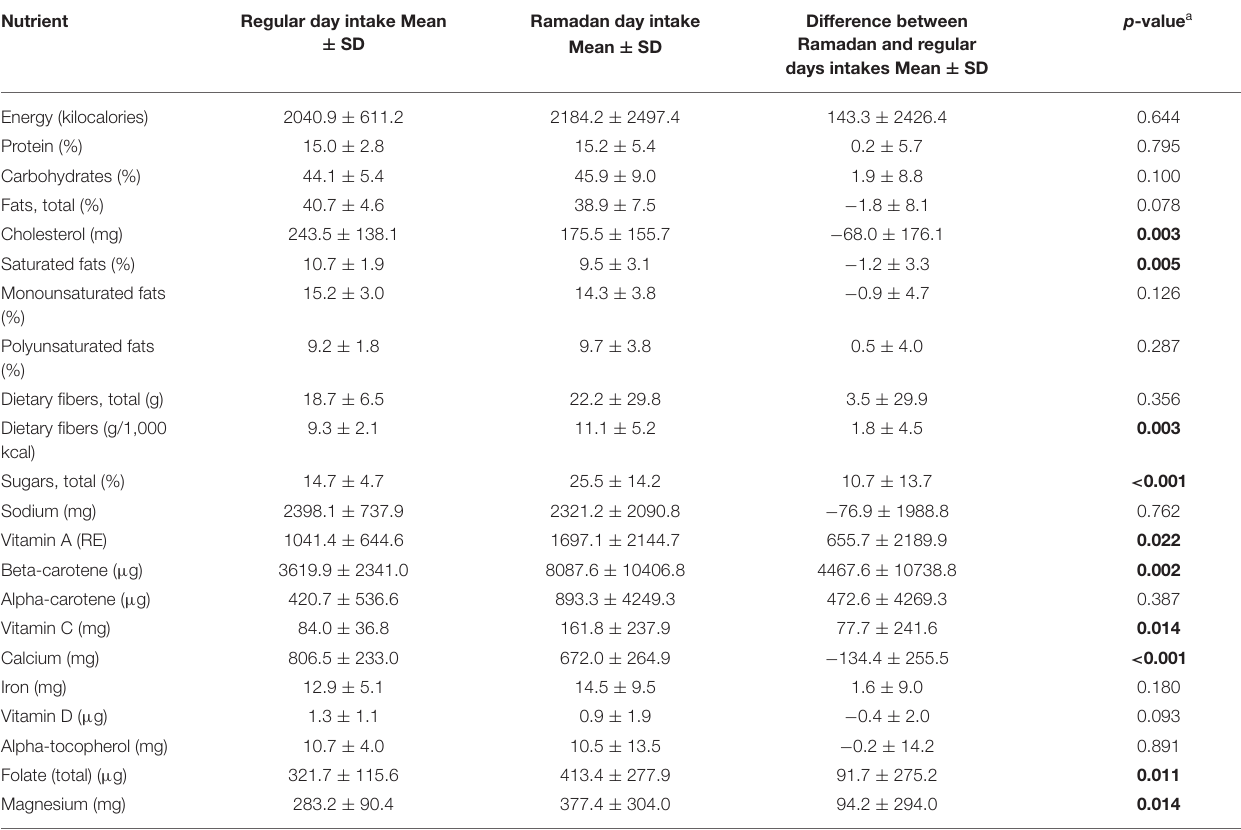
TABLE 3 | Energy, macro, and micronutrient consumption during regular days vs. the month of Ramadan among study participants ( n = 62).